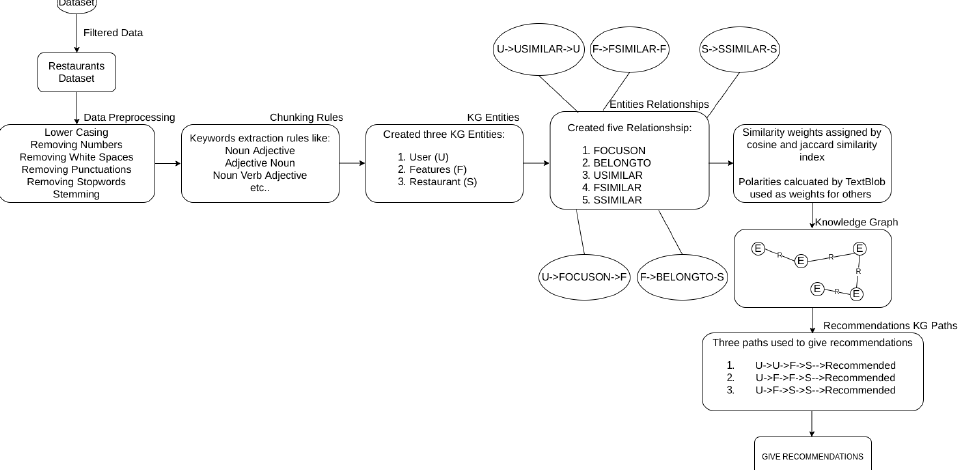
Figure 4. A flow diagram representing the end-to-end process of recommendation, including data processing, knowledge graph constructions, and